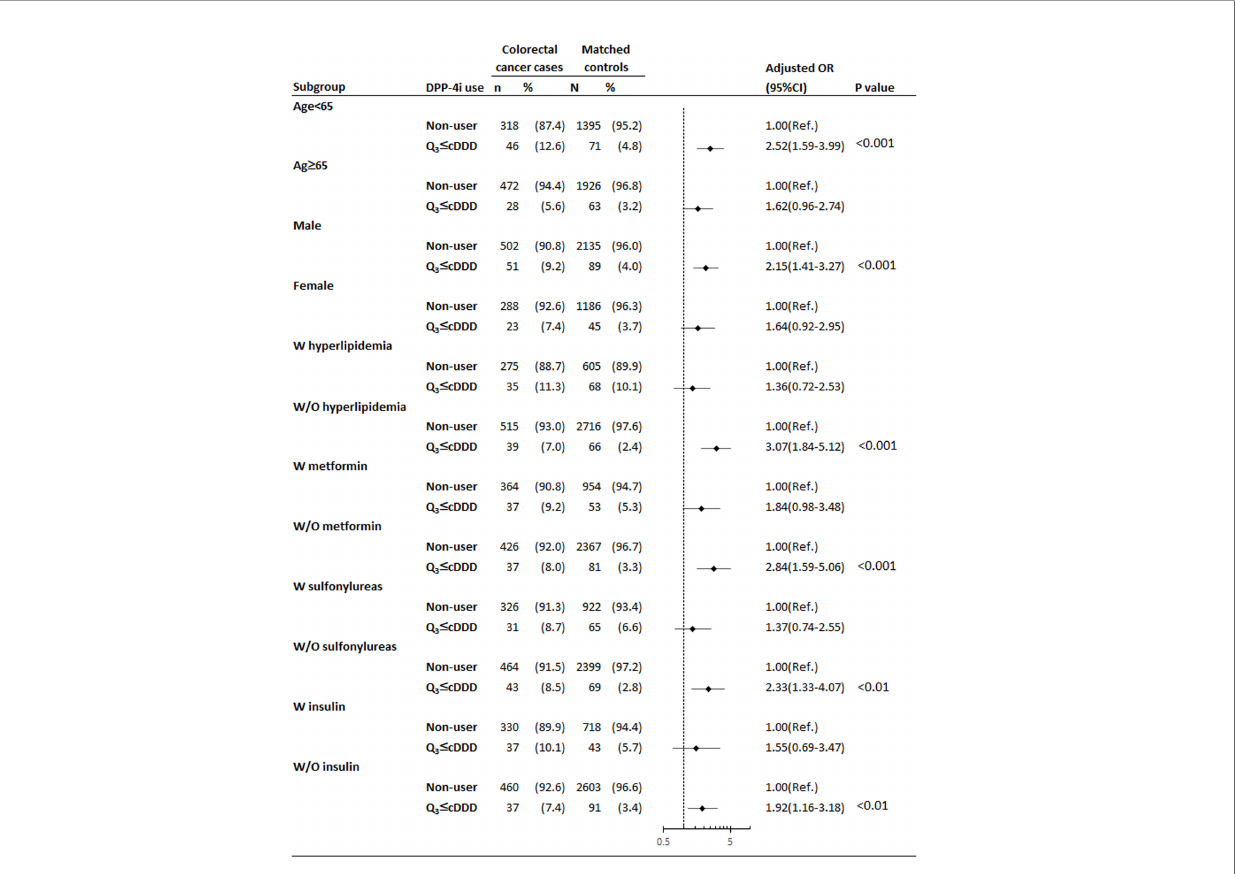
*Adjustment for the covariates listed in Table 1 . The abbreviations as in Table 2